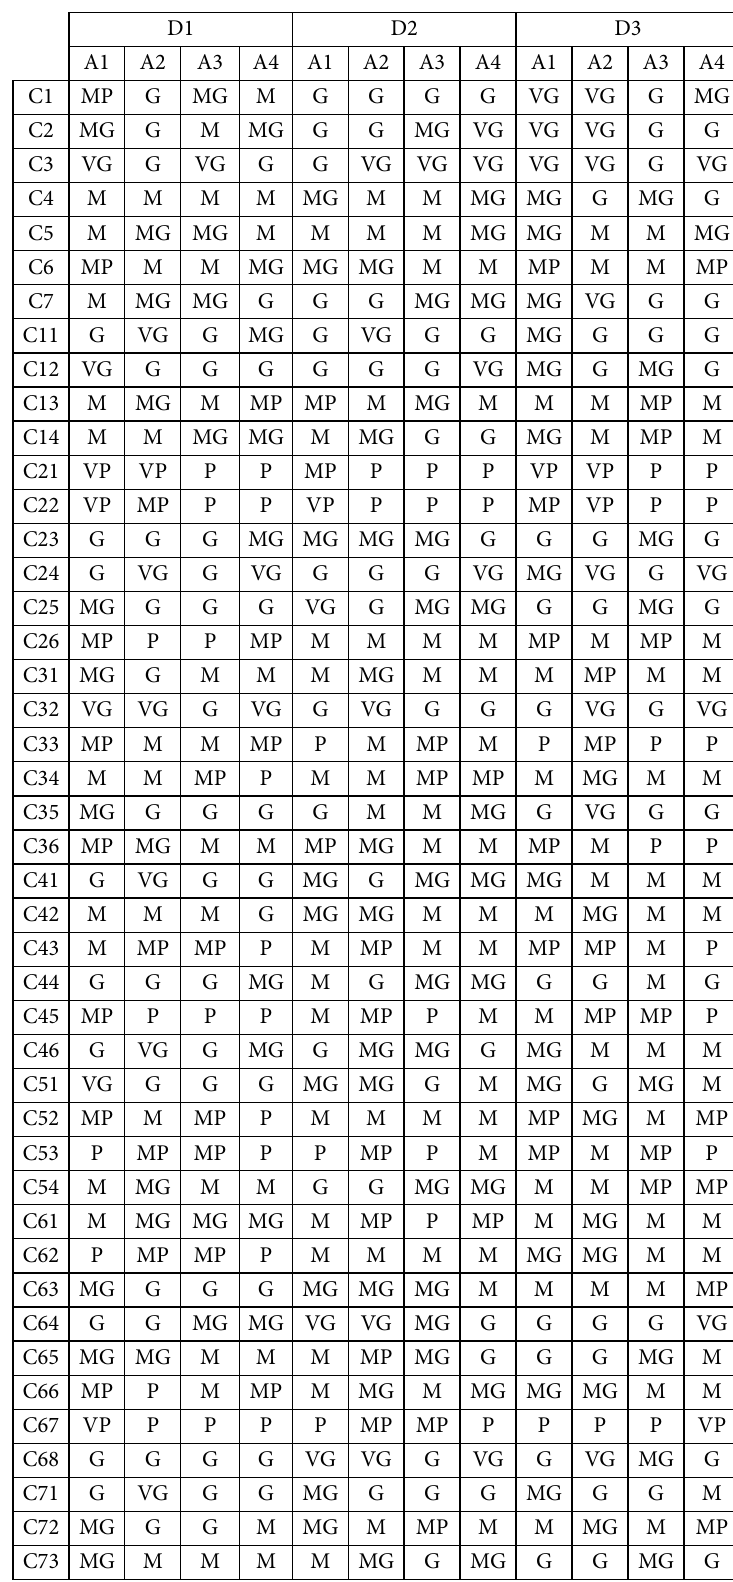
Table 4. Ratings of the alternatives with respect to the main criteria assessed by decision